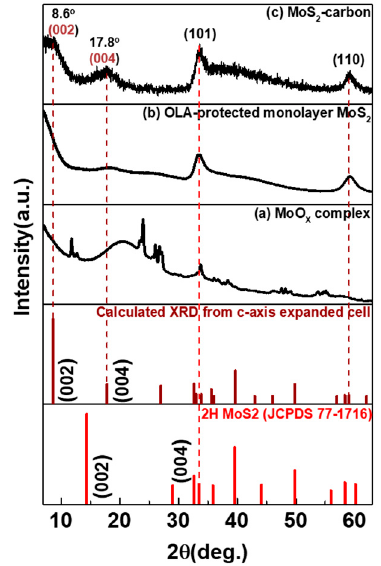
Figure 1. XRD spectra of as-prepared samples at different reaction temperatures and after the carbonization step. ( a ) MoO x complex, ( b ) oleylamine (OLA)-protected monolayer MoS 2 and ( c ) MoS 2 - carbon.